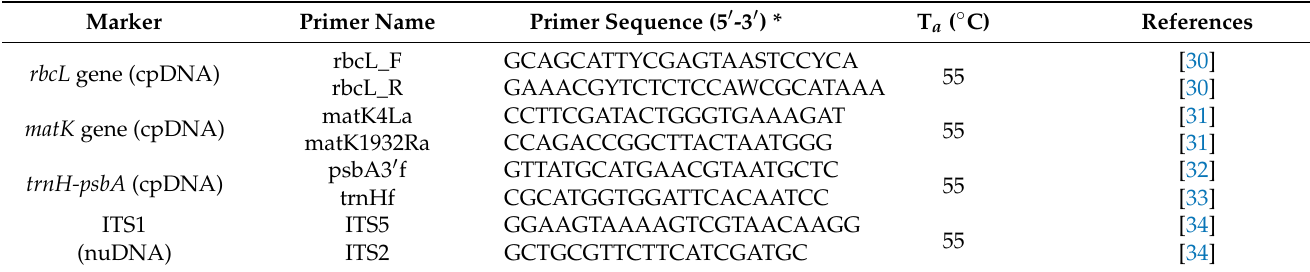
Table 1. List of primers used for each chloroplast (cpDNA) and nuclear (nuDNA) marker with their nucleotide sequence, and reference